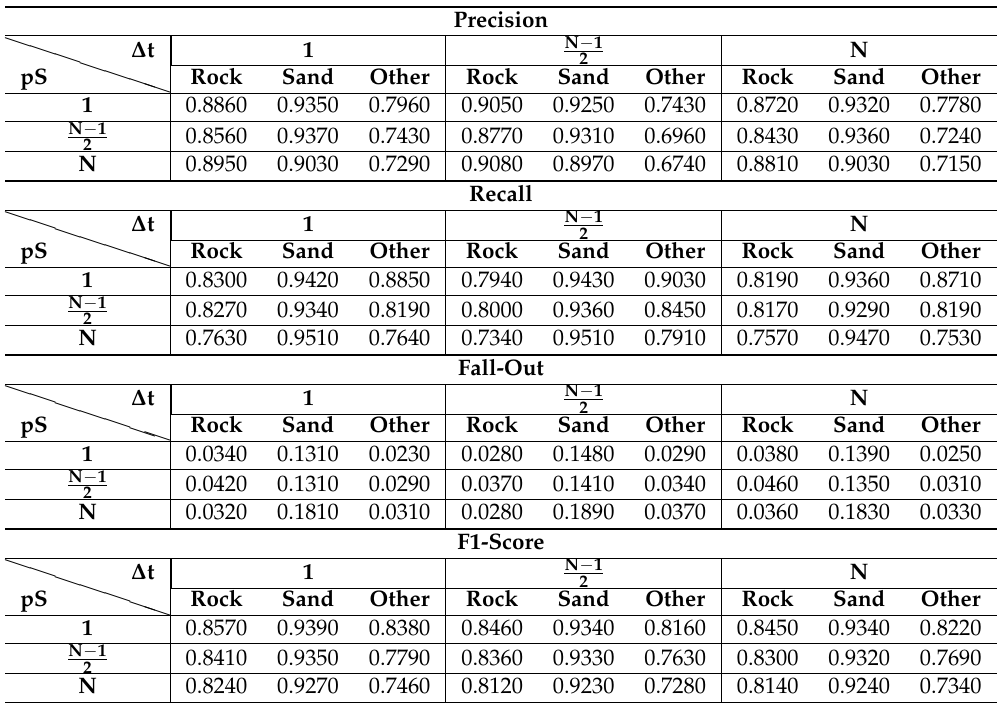
Table 6. Precision, recall, fall-out and F1-Score results when using